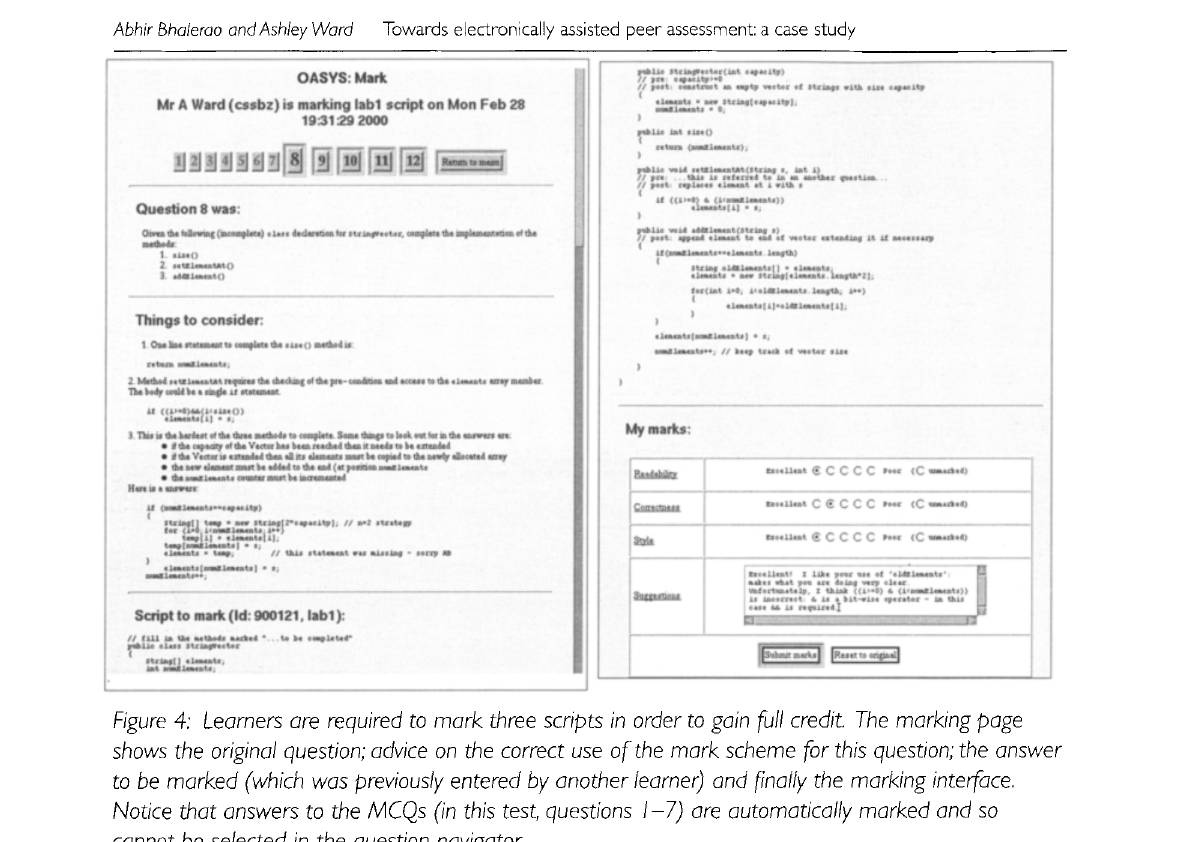
Figure 4: Leamers are required to mark three scripts in order to gain full credit. The marking page shows the original question; advice on the correct use of the mark scheme for this question; the answer to be marked (which was previously entered by another learner) and finally the marking interface. Notice that answers to the MCQs (in this test, questions I-7) are automatically marked and so cannot be selected in the question navigator.